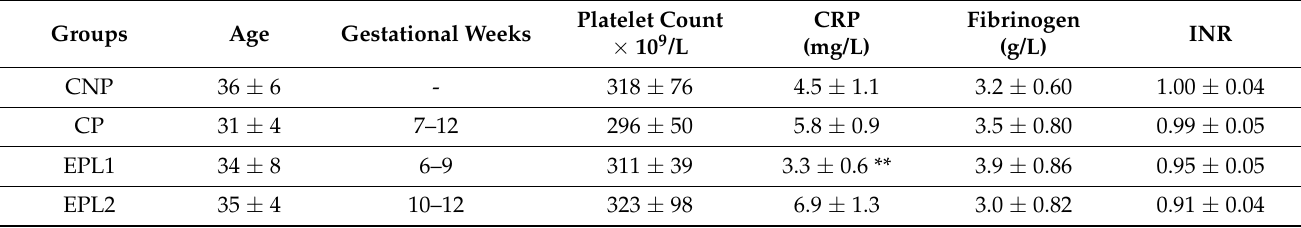
Table 1. Main characteristics and clinical parameters—platelets count, C-reactive protein (CRP) and fibrinogen concentration, and International normalized ratio (INR)—determined for the groups under study.